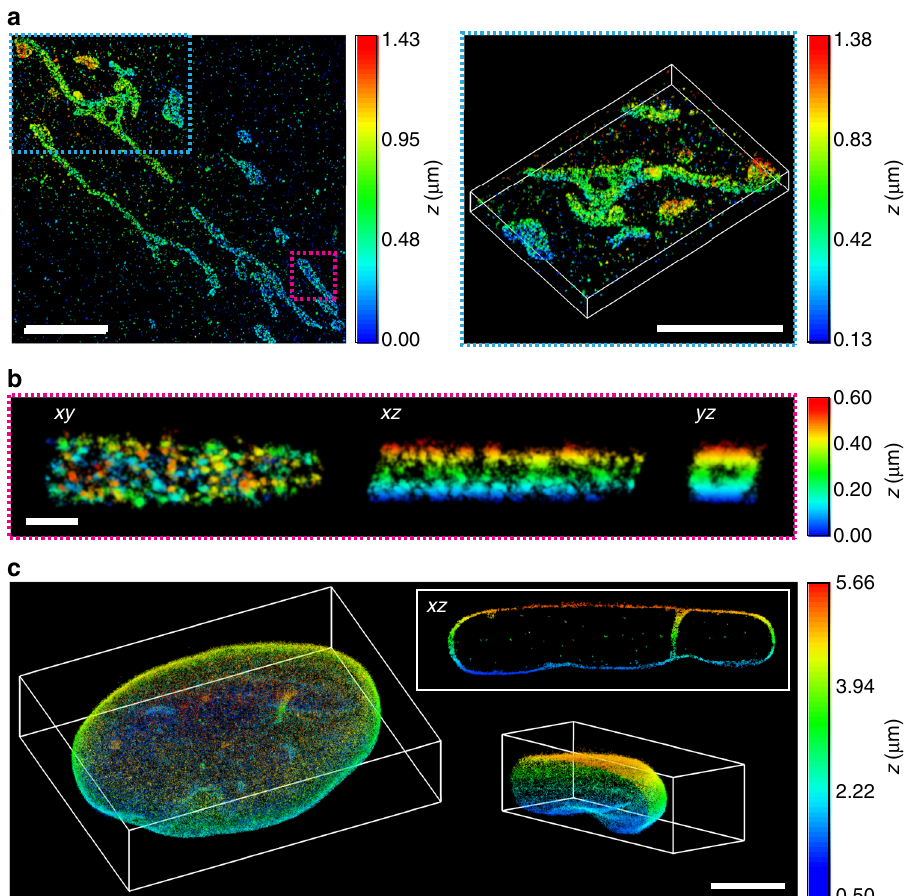
Fig. 4 Tilted light sheet imaging with long axial range point spread functions (PSFs). a 3D super-resolution (SR) reconstructions of mitochondria (TOM20) in a HeLa cell. The double-helix (DH) PSF was used for imaging of both single molecules and fi ducial beads. b xy , xz , and yz views of the mitochondrion shown in the magenta rectangle in a , revealing the hollow cylinder structure of the mitochondrial outer membrane. c 3D SR reconstruction of the entire nuclear lamina (lamin B1) in a HeLa cell. Imaging of single molecules and fi ducial beads was performed with the DH-PSF and a 6- µ m tetrapod PSF, respectively. The xz view shows a 1.3- µ m thick y -slice through the cell, where lamin meshwork enveloping an intranuclear channel is visible. The lower right inset shows the right cap of the reconstruction. All samples imaged were immunolabeled with Alexa Fluor 647. Scale bars are 5 µ m in a and c , and 500 nm in